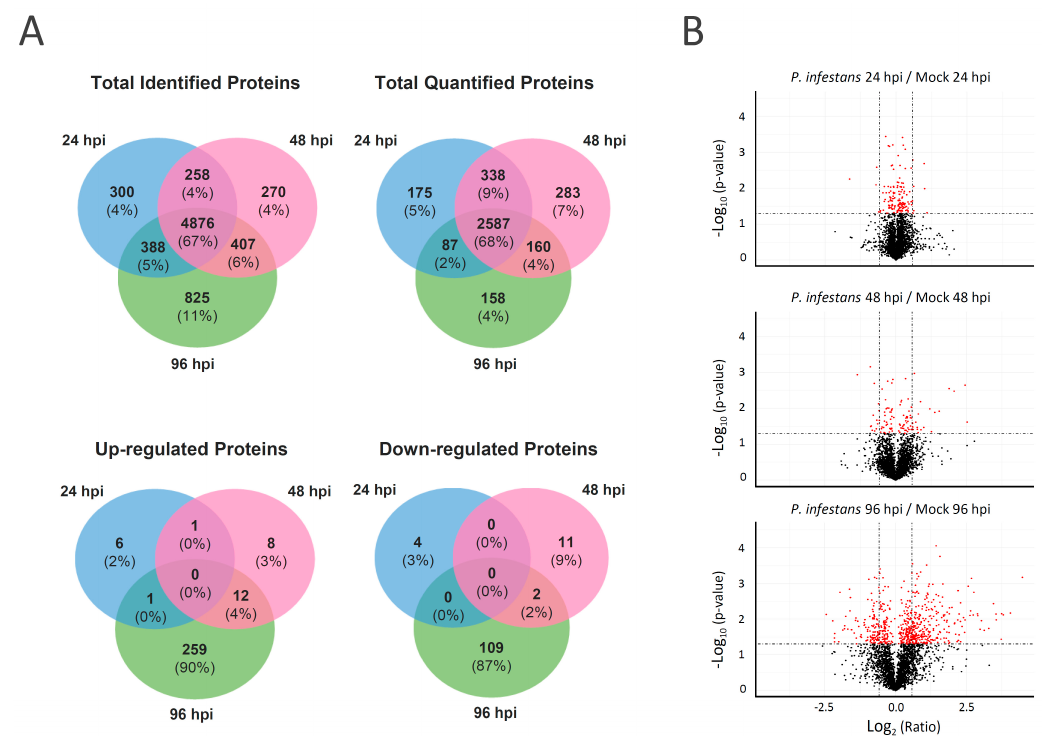
Figure 2. Proteome changes in tomato leaf between 24, 48 and 96 h post-inoculation with P. infestans compared to post- mock-inoculation at 24, 48, and 96 h, respectively . ( A ) Venn diagrams showing the unique and shared tomato or P. infestans proteins identified, quantified in three biological replicates, or showing a significant difference in abundance with a fold change greater than 1.5 or less than 0.67 in quantity ( p < 0.05) due to inoculation. ( B ) Volcano plots showing the protein abundance ratio of P. infestans -inoculated over the mock group at 24, 48 and 96 hpi. Following liquid chromatography-mass spectrometry (LC-MS) analysis and data-independent acquisition (DIA) quantification, t -test-based significance values (log 10 ( p -value)) were plotted versus log 2 (protein quantity ratio for all proteins between infected and mock). Differentially regulated proteins with p < 0.05 are plotted in red. A level of protein abundance change of 1.5 or 0.67-fold is marked with a dashed line.